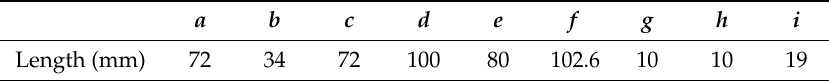
Table 1. Dimension of designed horn antenna.